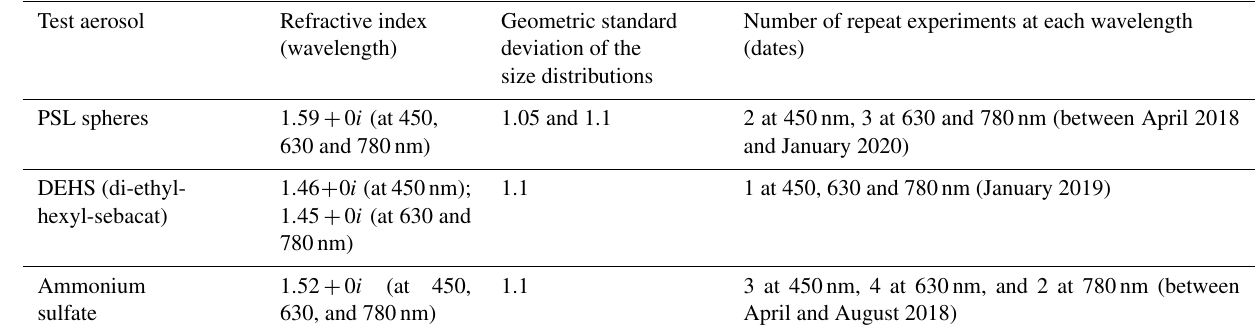
Table 3. Test aerosols used to measure scattered light truncation in the CAPS PMssa as a function of particle diameter and the values of parameters used in the corresponding model calculations. All particles were size classified by